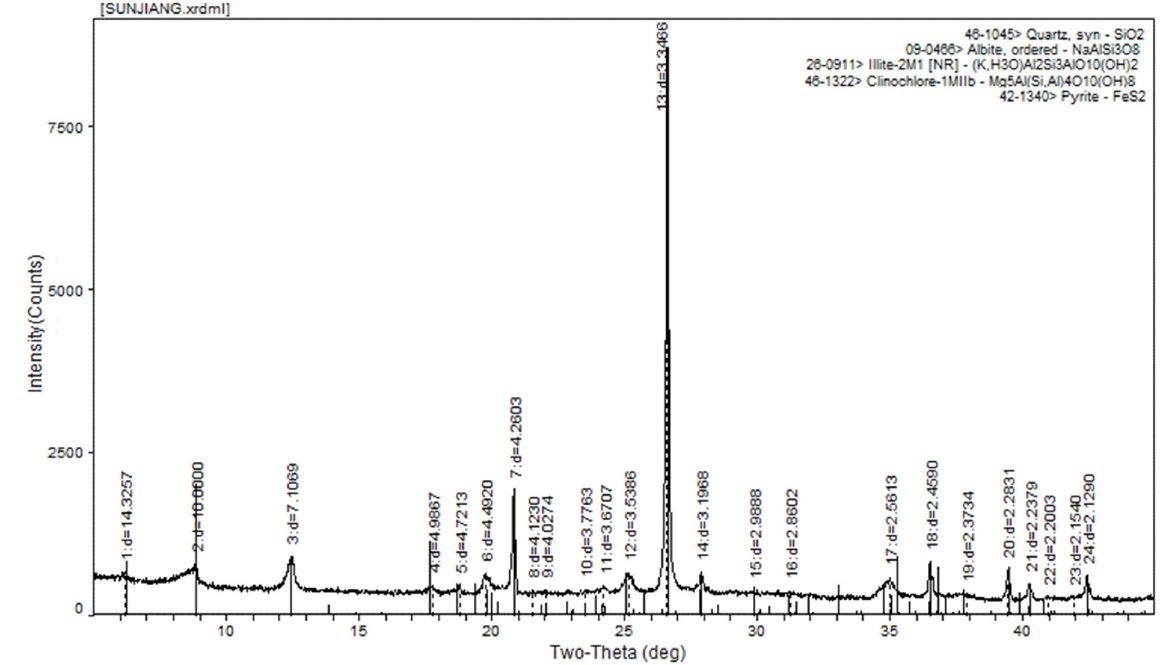
Figure 3. XRD test results of mudstone samples. Table 1. Main chemical composition of mudstone (%).